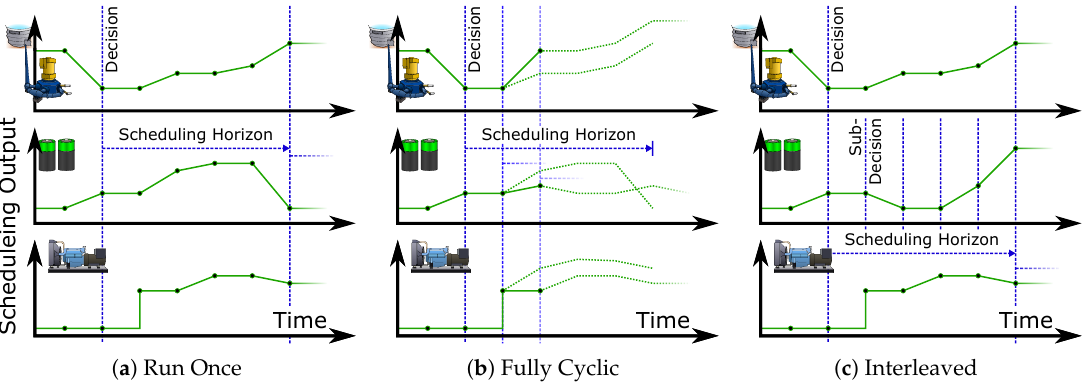
Figure 9. Observed scheduling